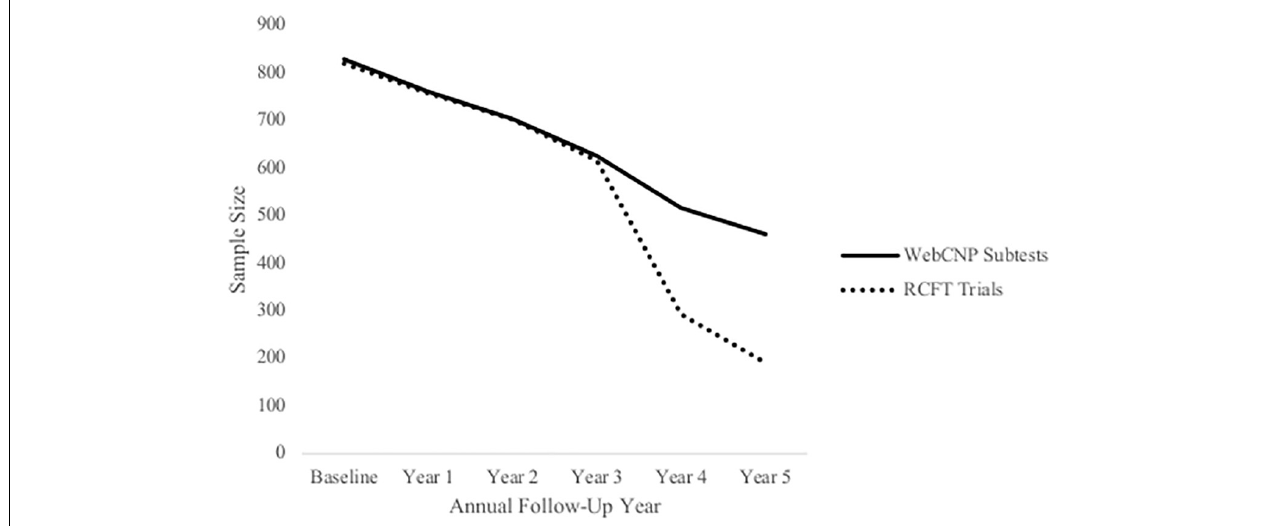
FIGURE 1 | Attrition within the National Consortium on Alcohol and Neurodevelopment in Adolescence (NCANDA) sample. This figure depicts sample size at each annual follow-up across 5 years based on participants who completed WebCNP measures (solid line) and all RCFT trials (dotted line) measures.